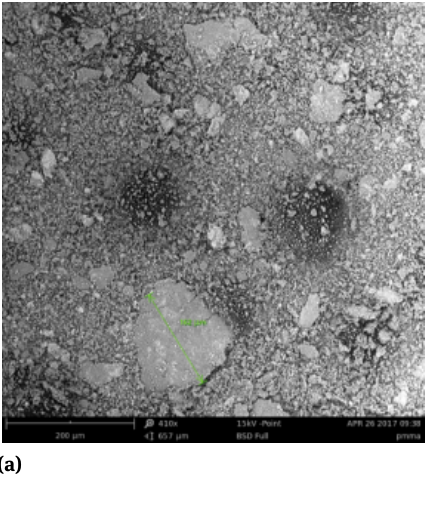
lustrate the effects of V % on properties at macroscales, θ various tests with different apparatuses were carried